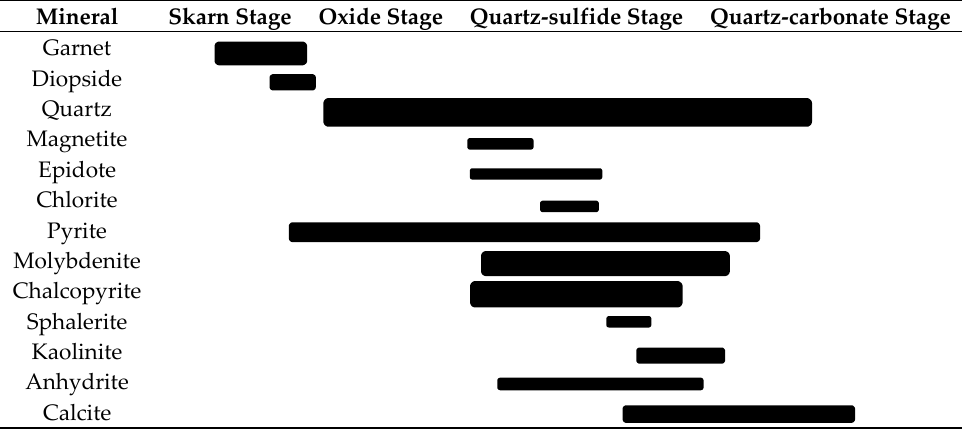
Figure 3. Hand specimens and photomicrographs of rock and mineralogy in the Hucunnan Cu–Mo deposit. ( a ) Granodiorite hand specimen; ( b , c ) granodiorite photomicrograph; ( d ) granular pyrite; ( e ) vein pyrite; ( f ) pyrite in skarn. Py, pyrite; Cpy, chalcopyrite; Kfs, K-feldspar; Bt, biotite; Q, quartz; Pl, plagioclase; Hbl, hornblende; Grt, garnet; Cal, calcite. Table 2. Minerals generated sequence table of the Hucunnan Cu–Mo deposit. Table 2. Minerals generated sequence table of the Hucunnan Cu–Mo deposit.